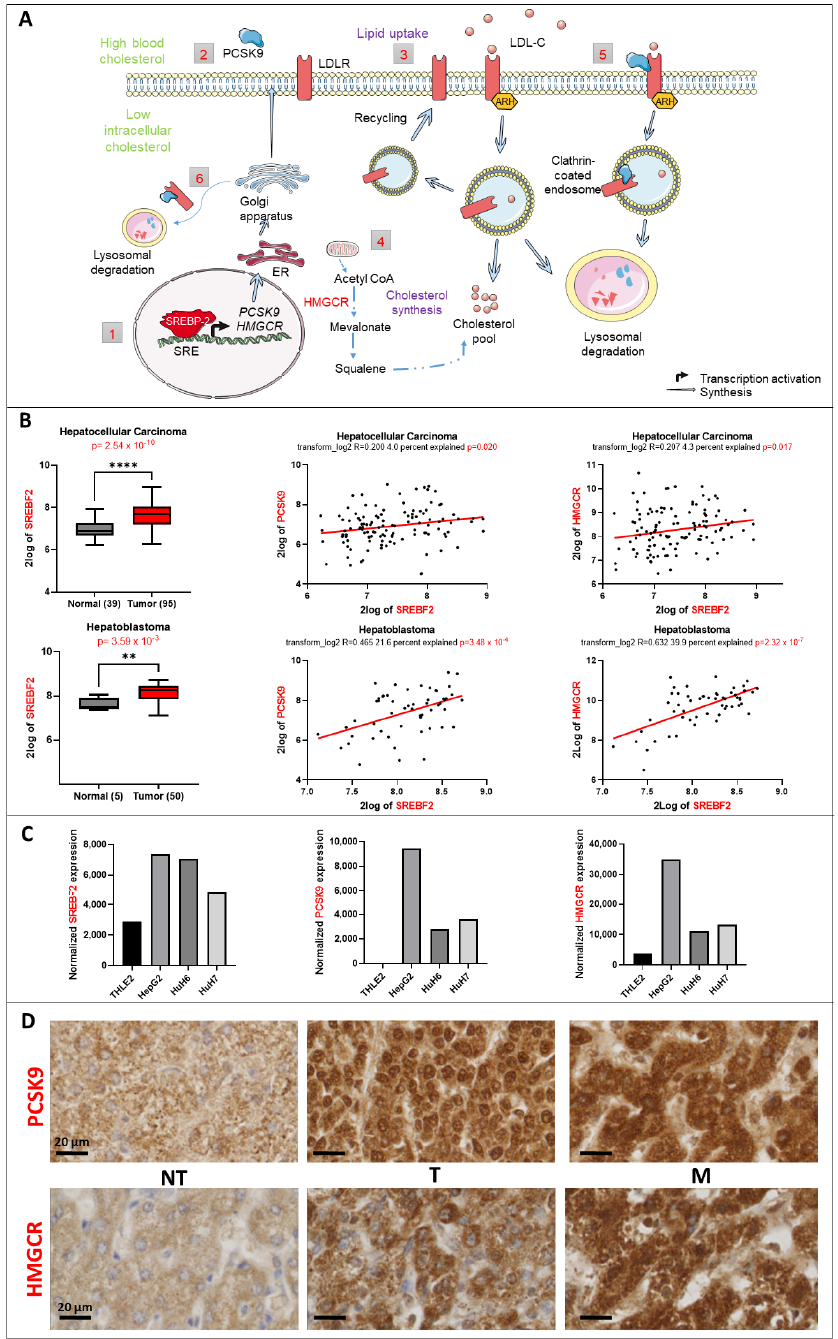
Figure 1. Lipid metabolic changes in liver cancer. ( A ) Control of the lipid metabolism by the transcription factor SREBP2. (1) SREBP2 is a transcription factor that regulates the expression of PCSK9 and HMGCR genes (2) The synthesis of PCSK9 is regulated transcriptionally by SREBP-2. Once translated, it will travel through the endoplasmic reticulum (ER) and Golgi apparatus for maturation before being secreted. (3) Lipid uptake: In response to high blood cholesterol, LDLR expressed on the cell surface will bind to LDL-cholesterol (LDL-C) and will be internalized in an autosomal recessive hypercholesterolemia (ARH)-dependent manner via clathrin-coated